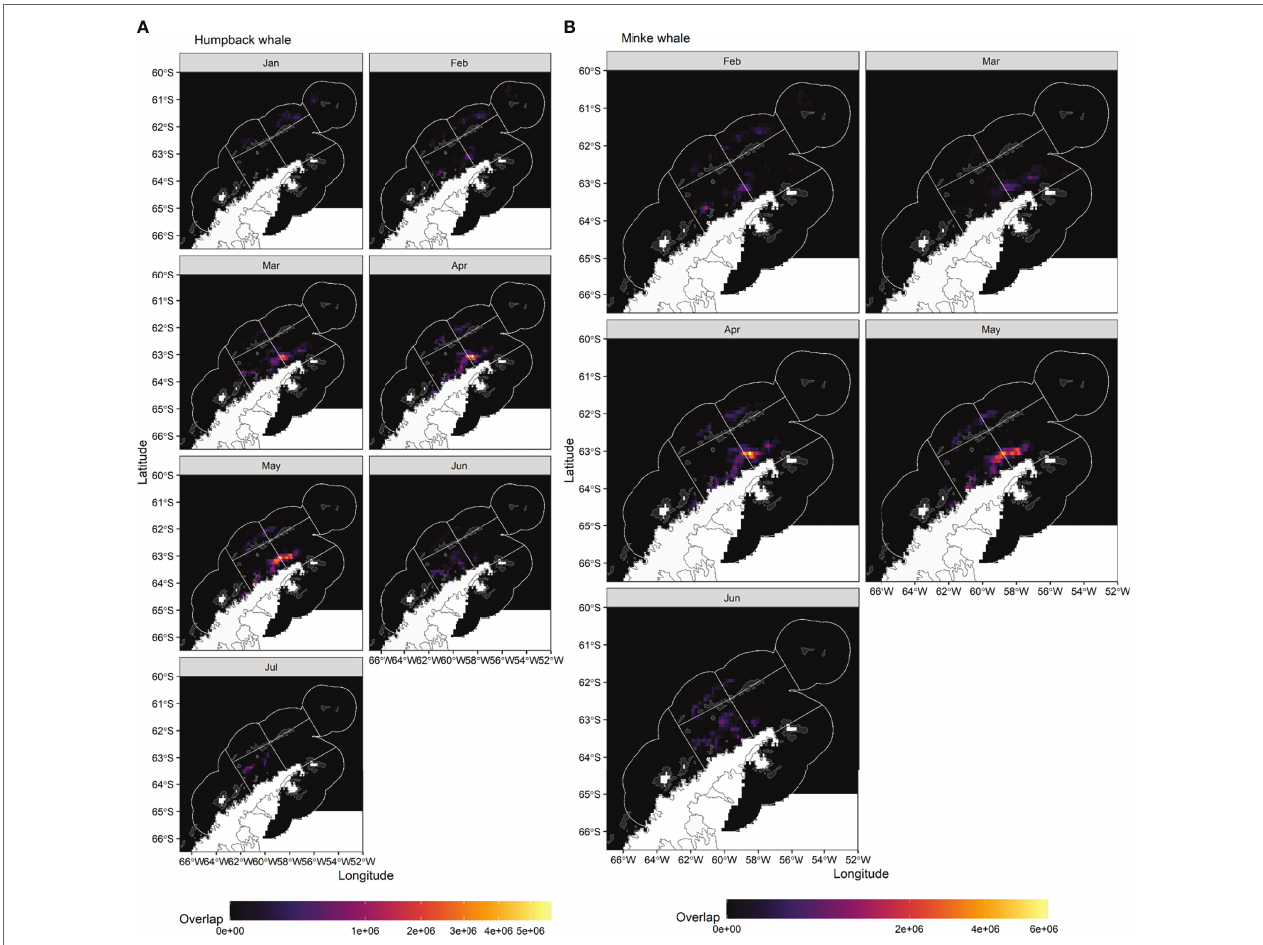
FIGURE 7 | Monthly overlap between (A) humpback whales and krill fishing and (B) minke whales and krill fishing, estimated as predicted probability of whales being in a restricted behavioural state in a given grid cell in a given month, multiplied by monthly fishing